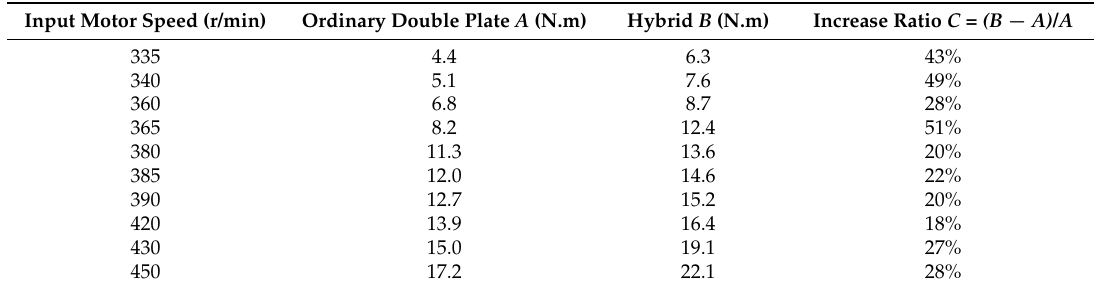
Table 2. Comparison data of the output torque test of the hybrid and ordinary double plate magnetic couplers.